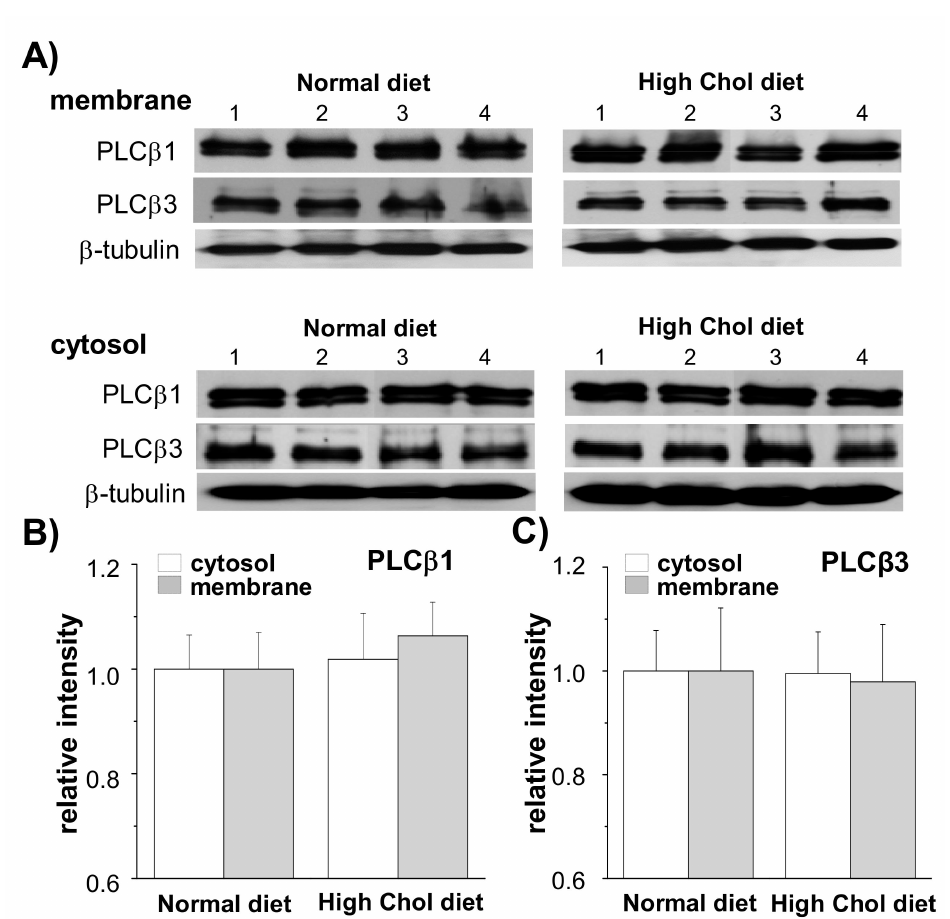
Figure 2. High-cholesterol diet slightly increased phospholipase C (PLC β 1) expression levels in the rat cerebral cortex. The expression levels of PLC β 1 and PLC β 3 were measured from the cytosol and membrane fractions of cerebral cortex using Western blot analysis. Representative Western blots are shown for PLC β 1 and PLC β 3. β -tubulin was used to confirm the amount of proteins loaded. ( A ) Expression levels of PLC β 1 and PLC β 3 were compared. ( B , C ) Bars indicate the levels of PLC β 1 ( B ) and PLC β 3 ( C ) obtained from densitometric analysis of Western bands in ( A ) ( n =